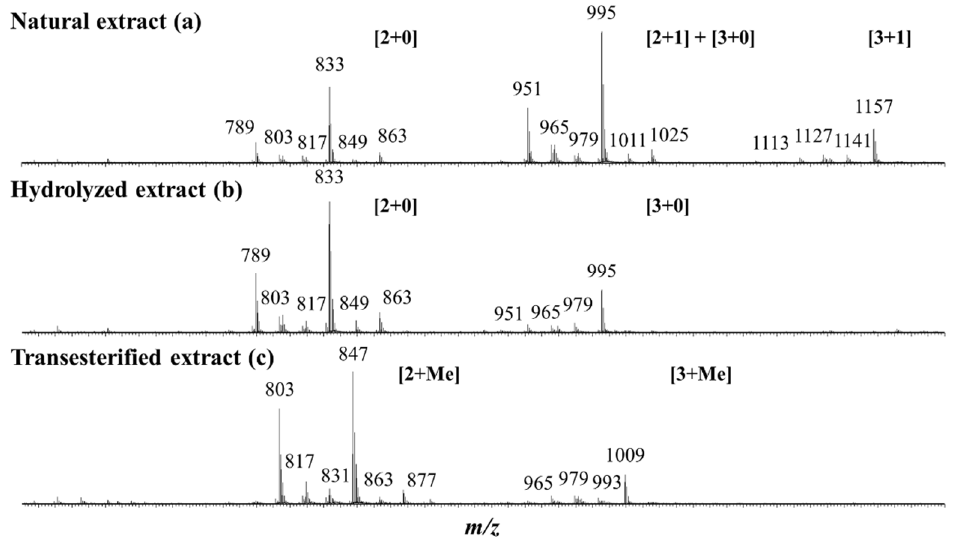
Figure 3. MALDI mass spectrometry analysis of three different saponin extracts: ( a ) the natural extract (NE); ( b ) the microwave-assisted alkaline hydrolysis (pH 10—150 ◦ C—5 min) reaction products; and ( c ) the transesterification using MeOK (MeOH anh —N 2 —60 ◦ C—60 min) reaction products. The saponin ion assignment was performed using the [x + y] symbolism, where x and y stand for the number of monosaccharide residues at C3 and C28, respectively. [x + Me] indicates that the C-28 glucose residue has been substituted by a methoxy group. Please note that the monodesmosidic [2 + 0] and [3 + 0] saponin ions detected in the NE ( a ) are produced during the MALDI processes from the corresponding bidesmosidic saponins (see text).